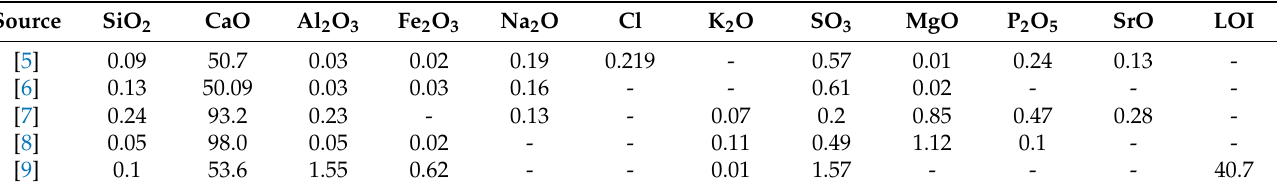
Table 1. Chemical composition of eggshell powder.